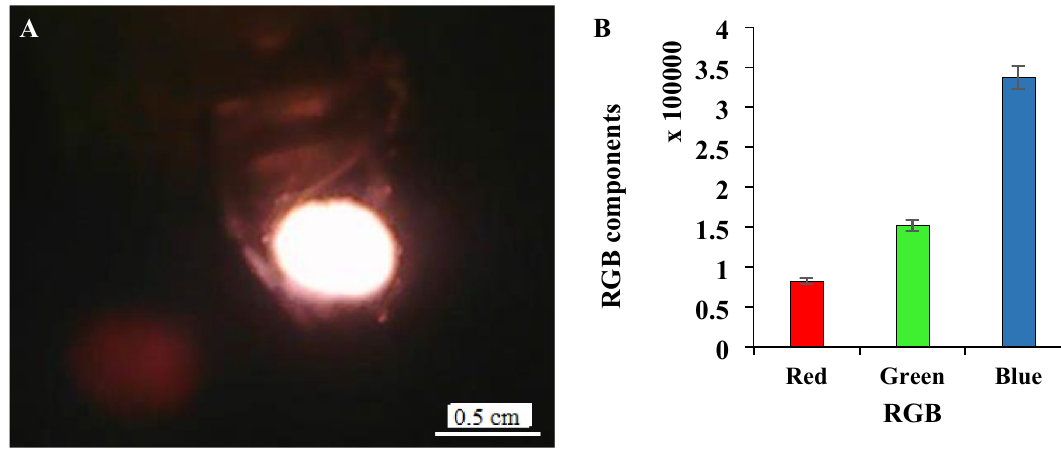
Figure 4. ( A , B ) Photographic image of thermionic emission of the W-filament and ( B ) histogram of red, green and blue components during introduction of 40–45% RH using filament with 6.00 ± 0.01 mm